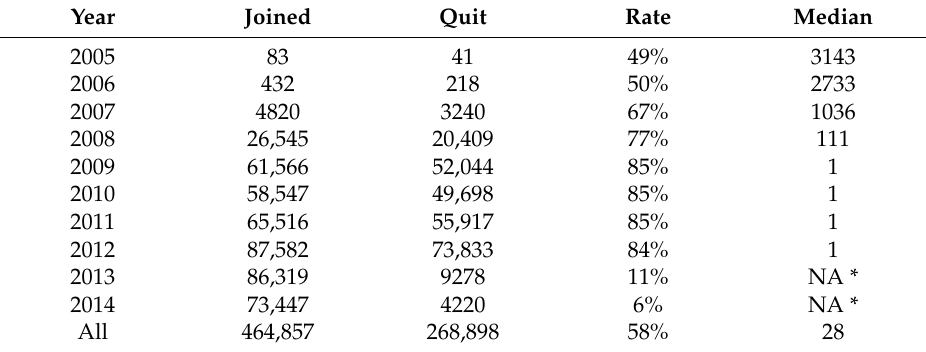
Table 2. Withdrawals per year of first contribution. For each year, “Joined” is the number of people who made a first edit in that year, “Quit” is the number of concerned people who withdrew from the project over years, “Rate” is the resulting proportion of contributors who withdrew over years, and “Median” is the number of days over which at least 50% of participants contributed to the